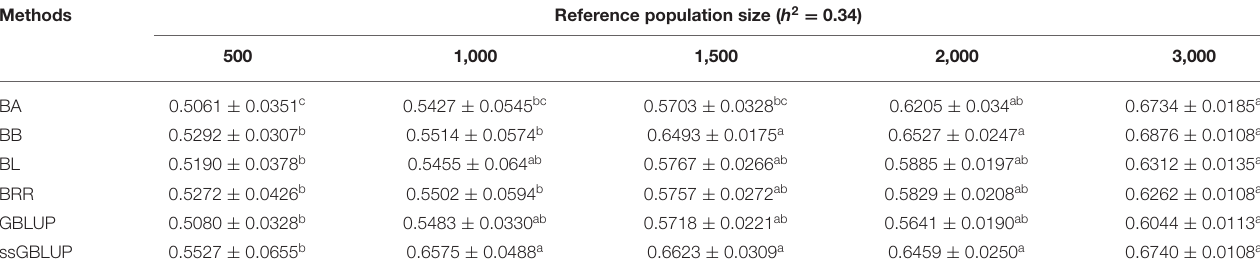
TABLE 4 | Accuracy of GEBV in five reference population sizes with heritability of fiber diameter under different models.